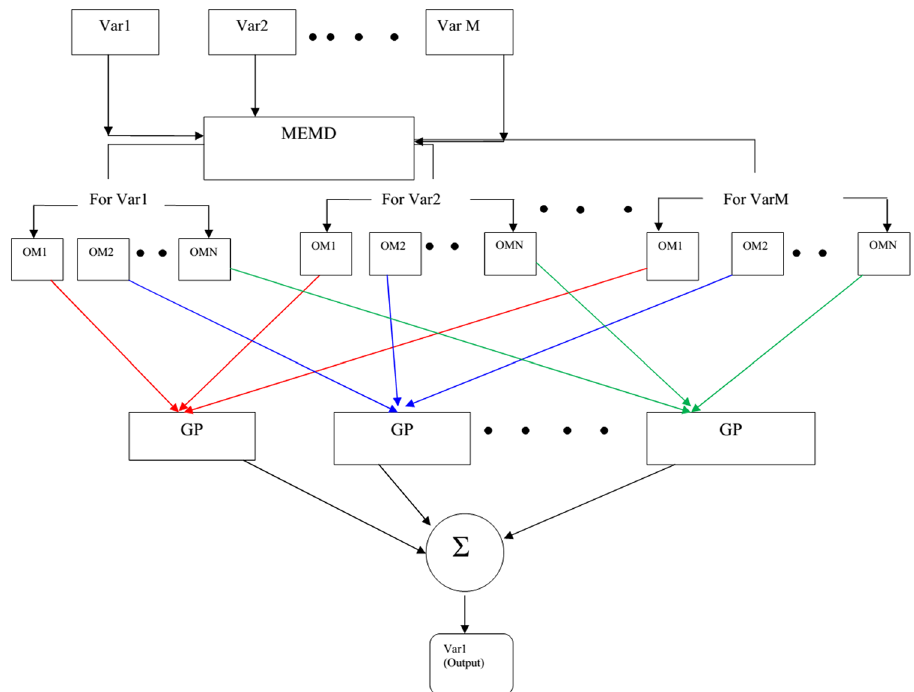
Fig. 2 Flowchart of MEMD–GP hybrid model. OM orthogonal mode; var1, var2, … var M —